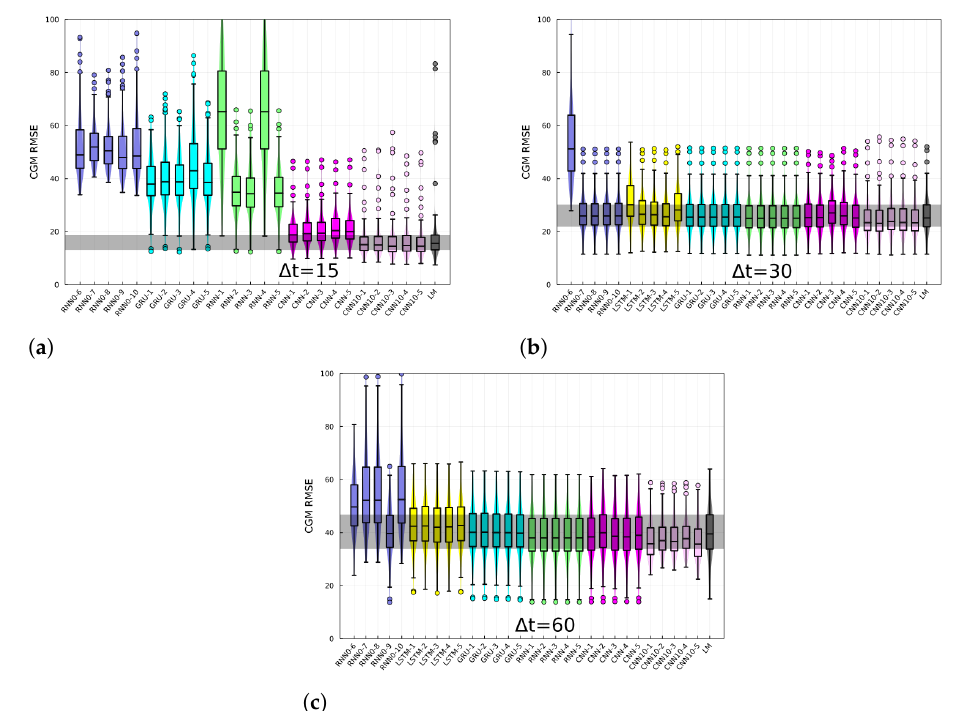
Figure 4. CGM prediction root mean squared error for ( a ) 15, ( b ) 30, and ( c ) 60 min horizons, and for different architectures. Each panels shows the RMSE for different architectures, specified in the x -axis and for the last-measurement prediction (LM). Each box corresponds to the model tested on N − 10 individuals.